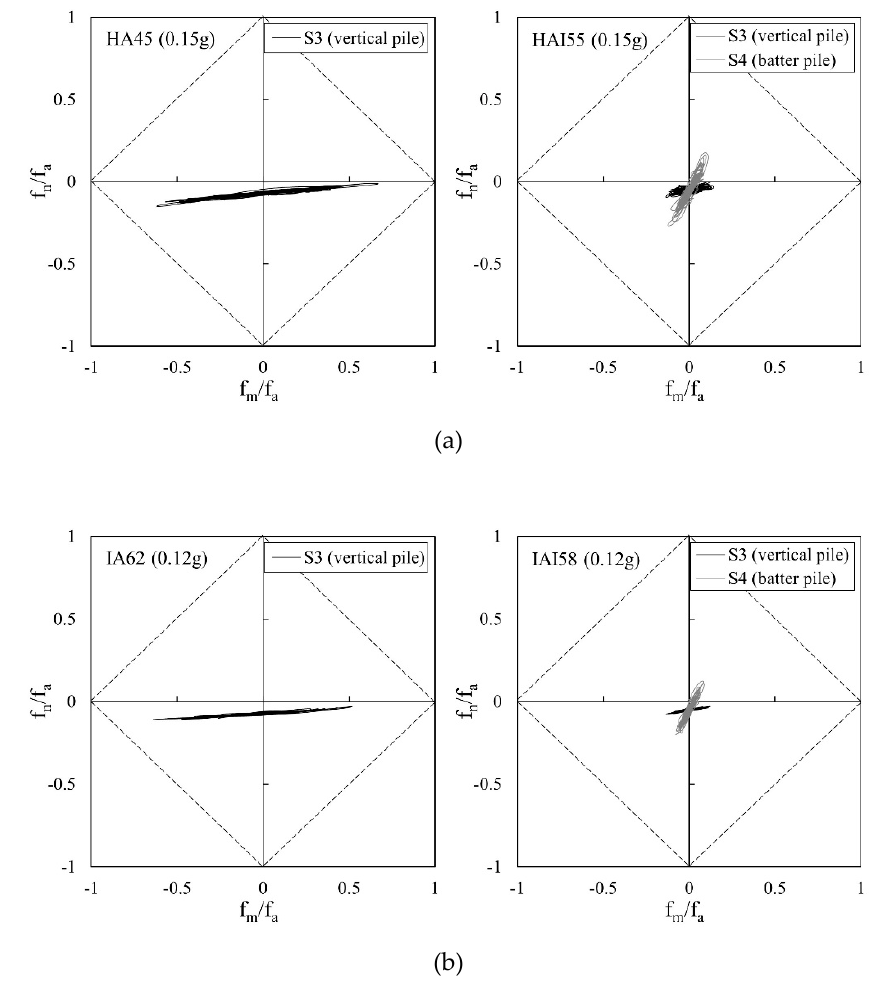
Figure 15. Relationship between bending moment and axial force (input peak acceleration ~0.12–0.15 g, scaled to the prototype): ( a ) horizontal ground model and ( b ) inclined ground model.